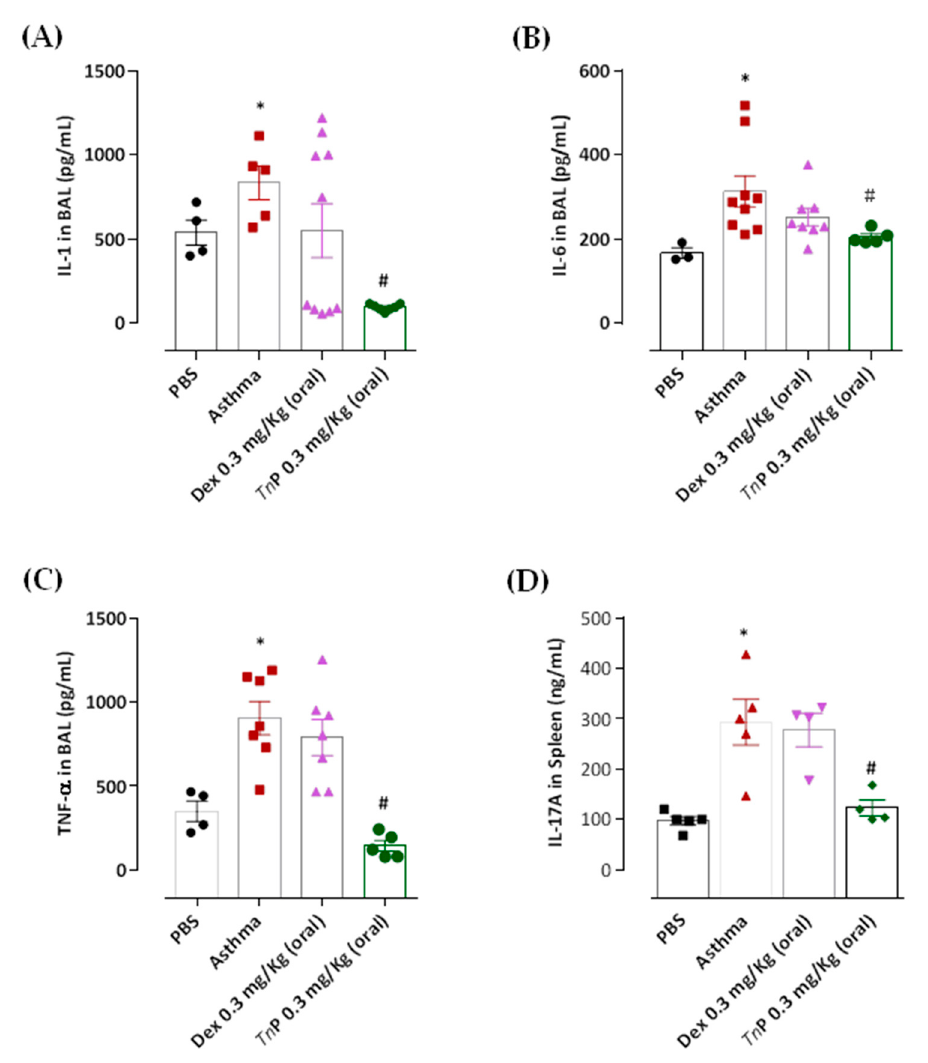
Figure 7. Tn P suppresses pro-inflammatory cytokine production. OVA-sensitized mice subjected to challenge with aerosolized OVA, submitted or not to treatment with Tn P or Dexa, were killed after 24 h for analysis of IL-1 β ( A ), IL-6 ( B ), TNF- α ( C ) in BAL and IL-17 in the spleen ( D ), by cytometric bead array. * p < 0.05 compared to the PBS control group and # p < 0.05 compared to the asthma group.